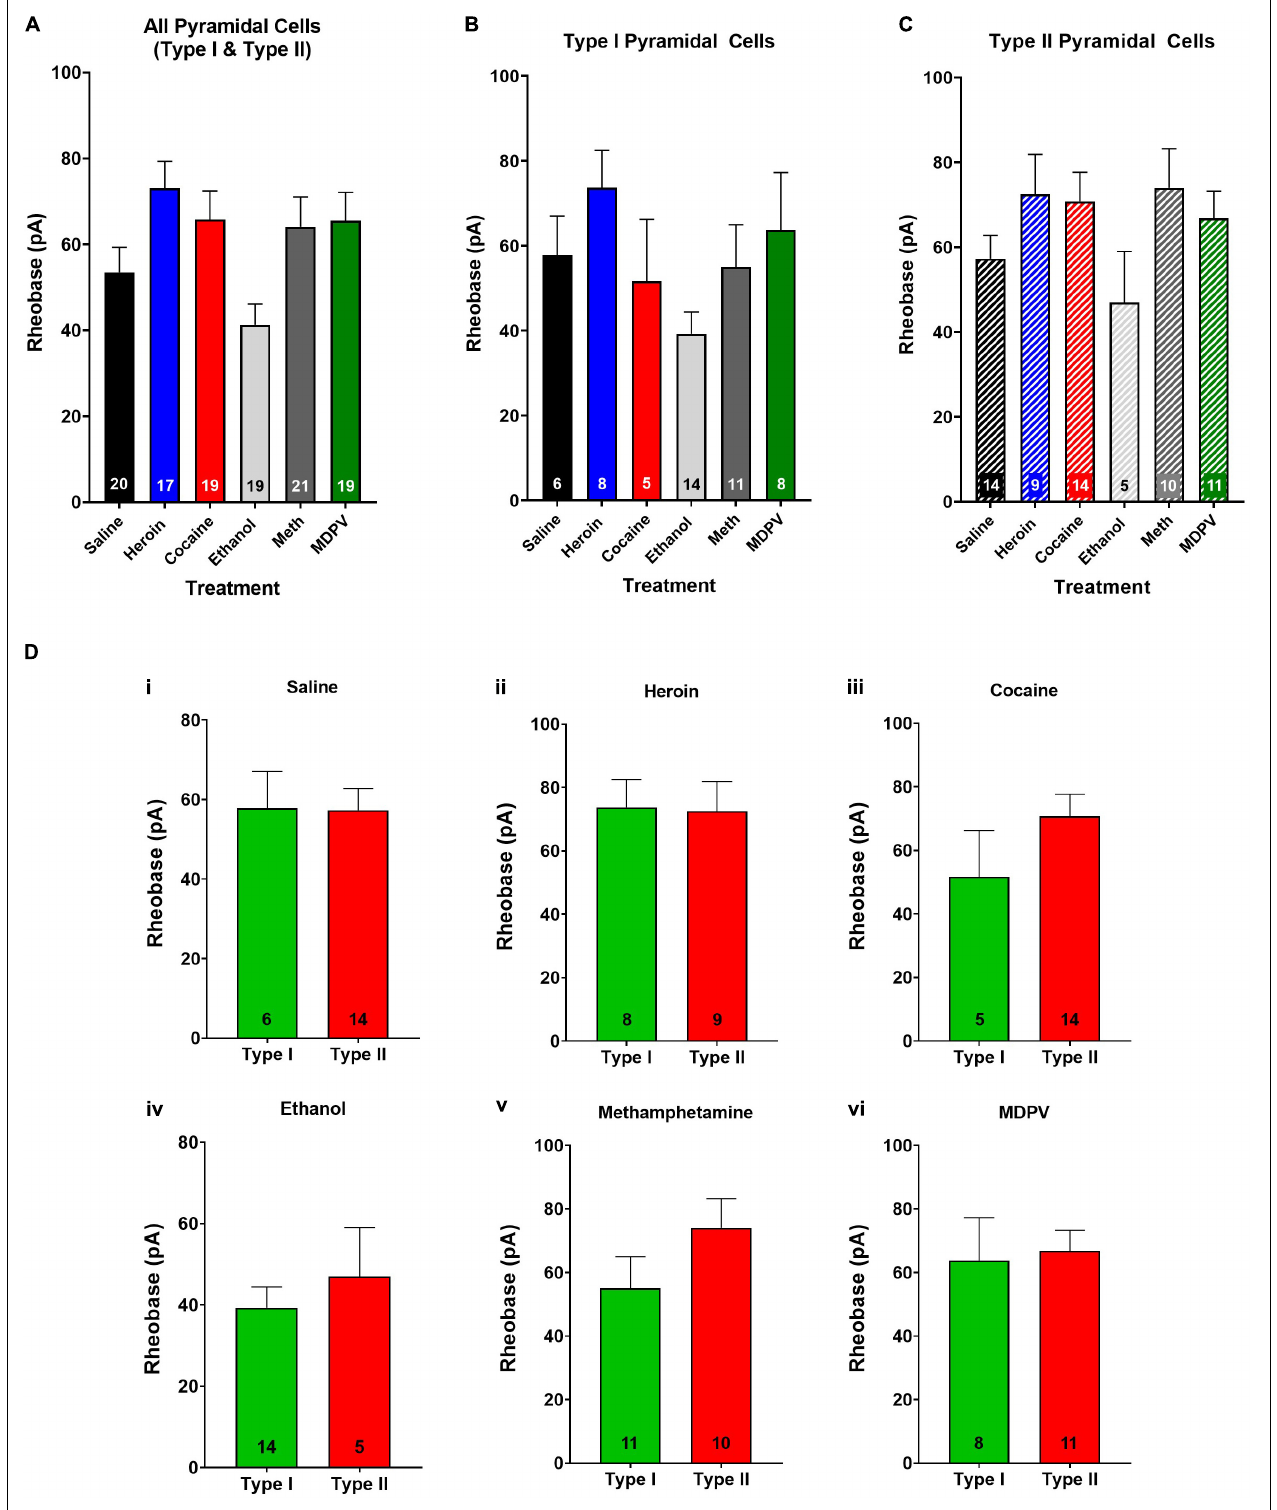
FIGURE 4 | Rheobase of layer V pyramidal cells is not altered by drug treatment and does not differ between pyramidal subtypes. (A) Drug exposure does not alter the rheobase of layer V pyramidal cells, regardless of subtype (B,C) . The rheobase of type I and type II cells did not differ within saline (Di) , heroin (Dii) , cocaine (Diii) , ethanol (Div) , methamphetamine (Dv) , or MDPV (Dvi) treated animals. Numbers within histogram bars represent the number of recorded cells.